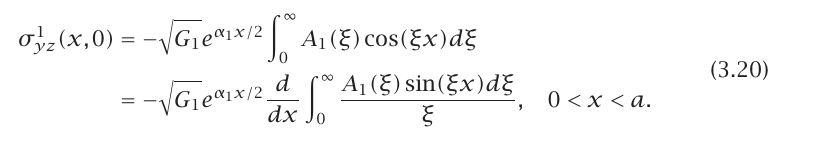
Figure 3.7 . Variation of σ 1 yz (x, 0 )/G = 0 . 1 , 0 . 3 , 0 . 5 , 0 . 7, a = 1 . 3, G = 5, α α 1